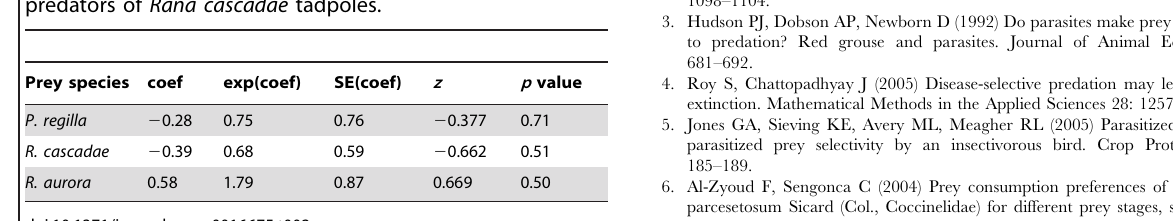
Table 2. Survival analysis using Cox proportional hazards of amphibian prey species from predation by two salamander species: Taricha granulosa predators on tadpoles of Pseudacris regilla and Rana aurora , and Ambystoma macrodactylum predators of Rana cascadae